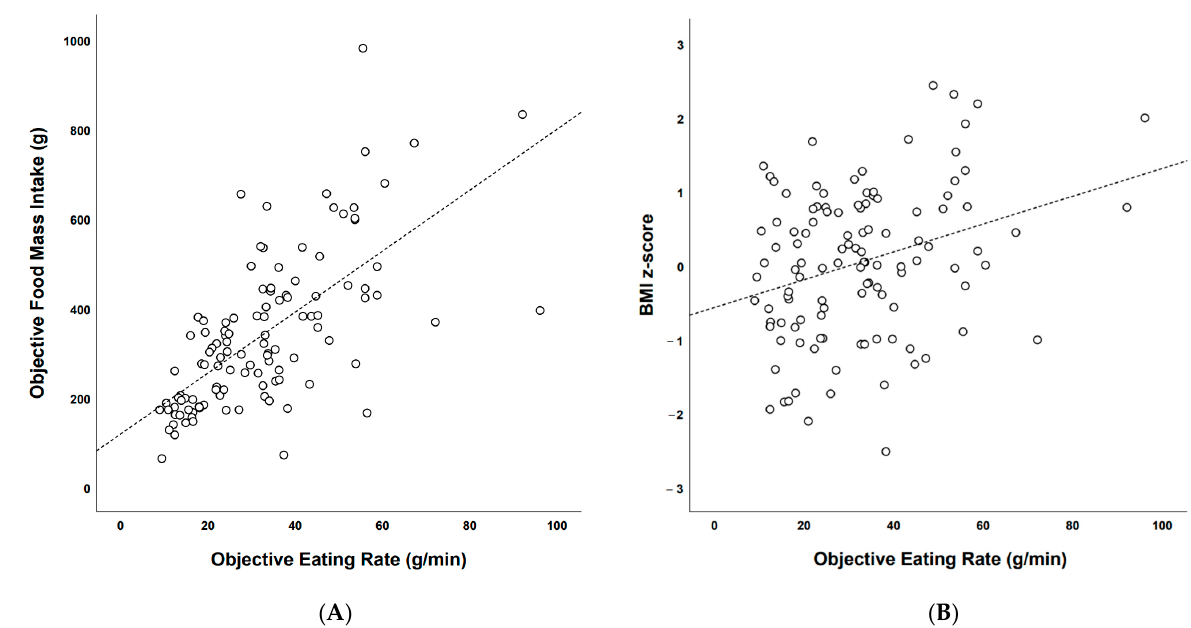
Figure 3. ( A ) Scatter plot illustrating the correlation between food mass intake (g) and objective eating rate (g/min) during the school lunch. ( B ) Scatter plot illustrating the correlation between BMI z-scores and objective eating rate during the school lunch (g/min).